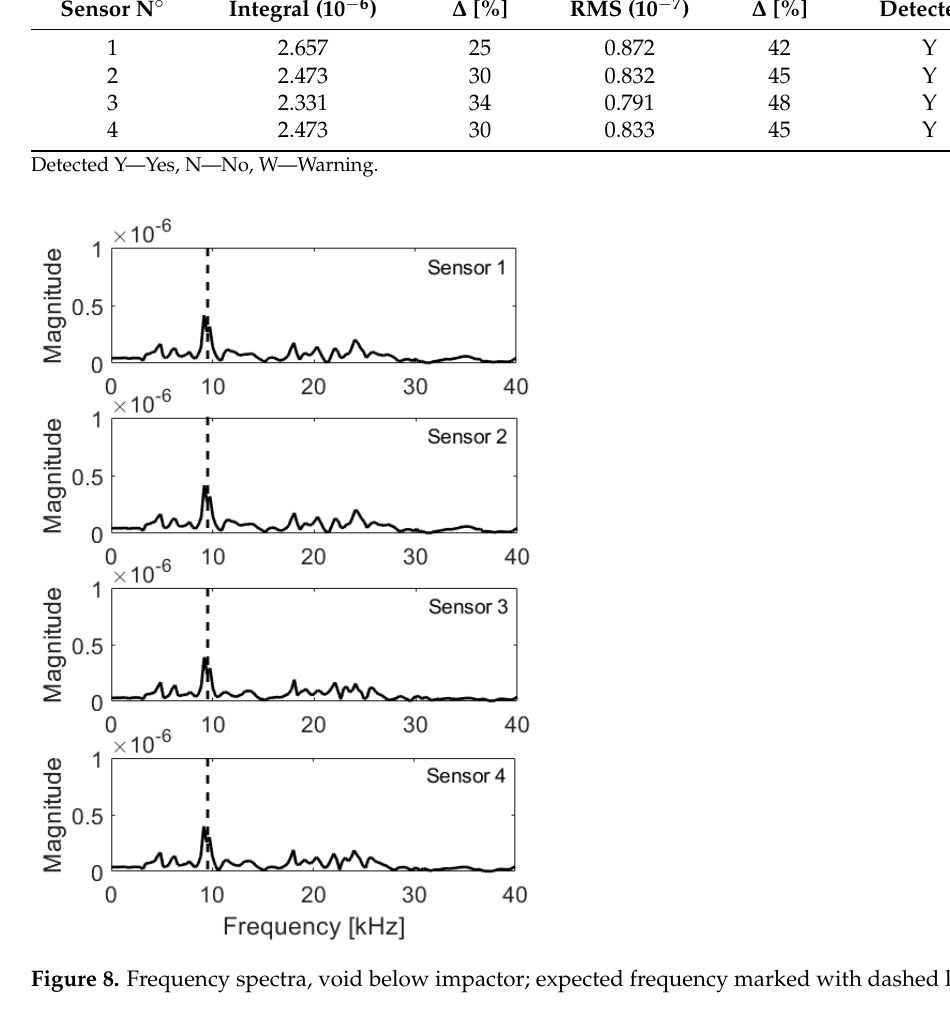
Figure 7. Scheme of void and IE device layout. Table 3. Integral and RMS of frequency spectrum, void below impactor.